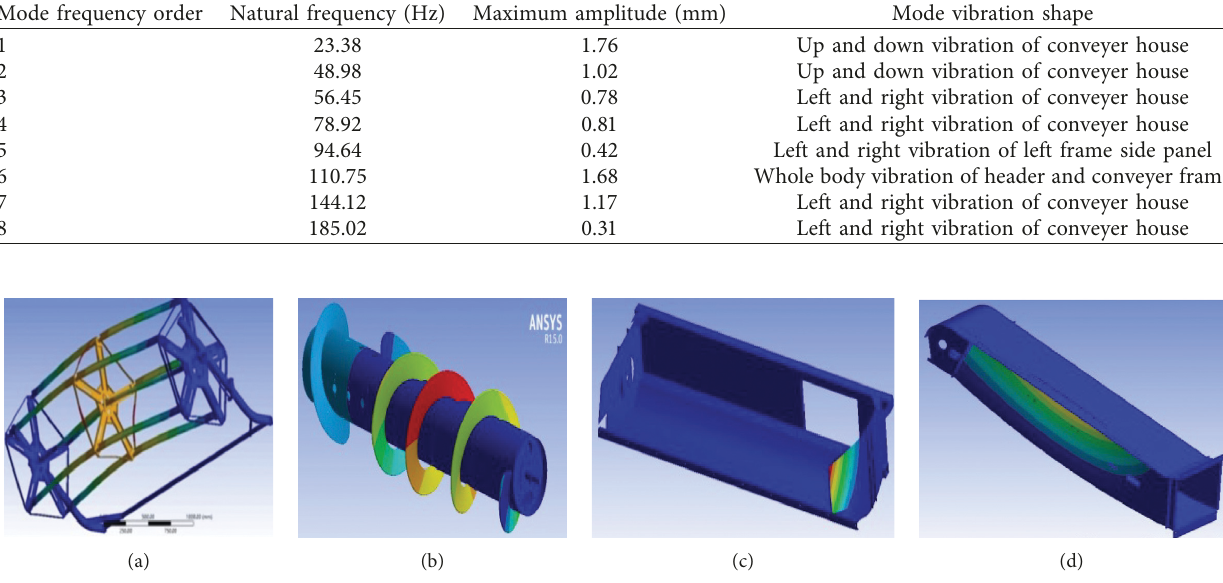
Table 2: Mode vibration frequency and shape of front header.